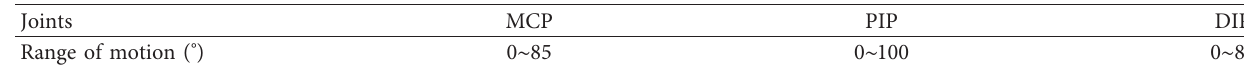
Figure 7: Prototype of the HMD. Table 2: Range of variation of each finger joint.